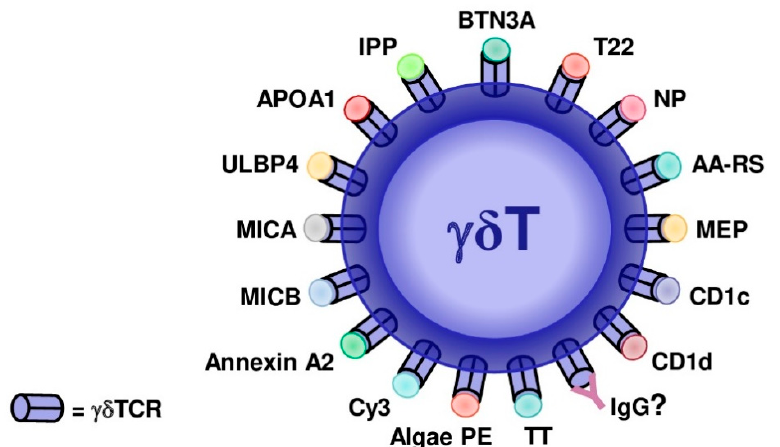
Figure 1. Evidenced and proposed γδ TCR ligands in mice and humans. Butyrophilin-3 (BTN3A), nonclassical MHC molecule T22, 4-hydroxy-3-nitrophenylacetyl (NP), aminoacyl-tRNA synthetases (AA-RS), monoethyl phosphate (MEP), CD1c, CD1d, toxoid of Clostridium tetani (TT), algal phycoerythrin (PE), cyanine 3 (Cy3), annexin A2, MICB (MHC class I chain-related protein B), MICA (MHC class I chain-related protein A), ULBP4, APOA-1 (apolipoprotein A-1), isopentenyl pyrophosphate (IPP), and IgG are illustrated. ? = proposed non-evidenced ligand.